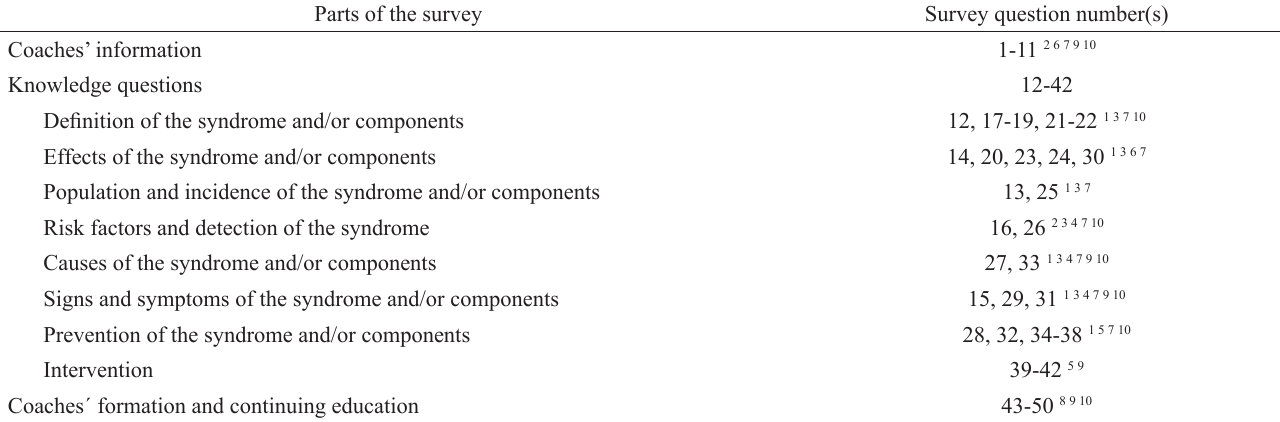
Table 1. Structure of the survey (parts and topics of the different questions of the survey) and references used to develop the survey.